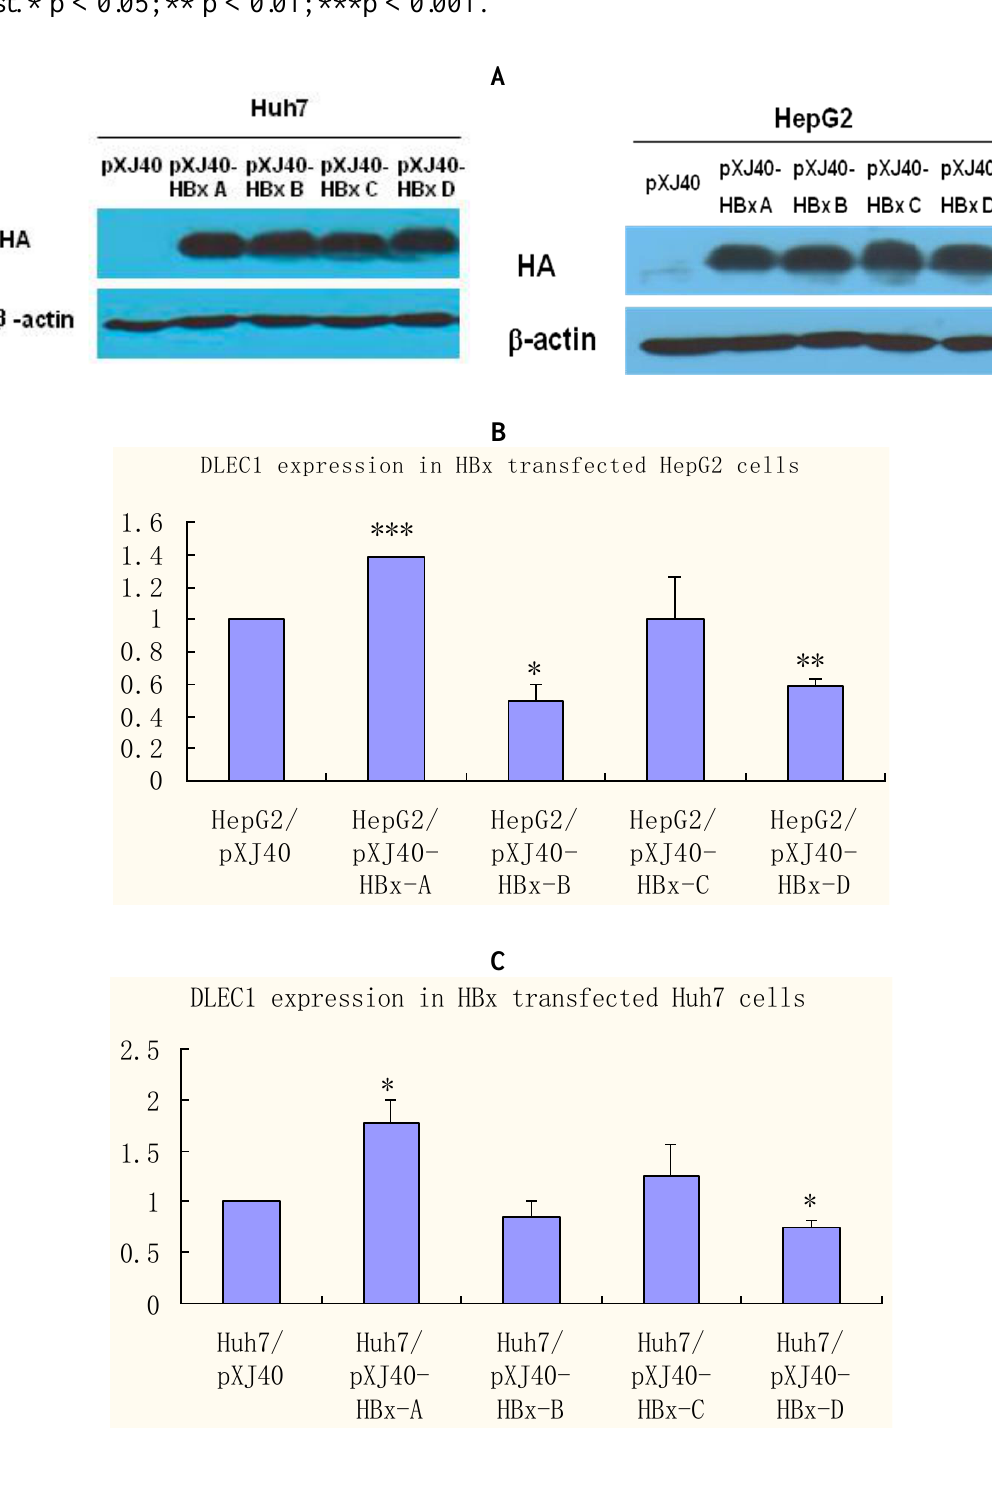
Figure 4. DLEC1 expression in HBx genotype A-D expressing HepG2 and Huh7. (A) Western analysis of HBx expression in HepG2 and Huh7 cells. HBx expression was detected by HA tag contained in the vector pXJ40. β-actin was detected as the internal control. (B) Analysis of DLEC1 expression in HBx genotype A-D expressing HepG2 by real-time RT-PCR. (C) Analysis of DLEC1 expression in HBx genotype A-D expressing Huh7 by real-time RT-PCR. Experiment was done three times. pXJ40 was included as an empty vector control. Experimental differences were tested for statistical significance using t-test. * p < 0.05; ** p < 0.01; ***p <